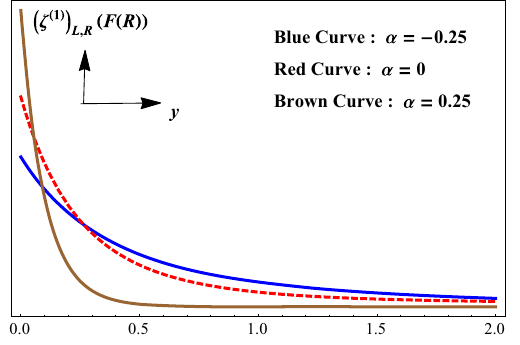
( = ζ ( 1 ) ( F ( R )) in the diagram) vs. y for M = 1, (cid:9) = − 1 Fig. 5 ζ ( 1 ) L , R L , R and m 5 = 0 .